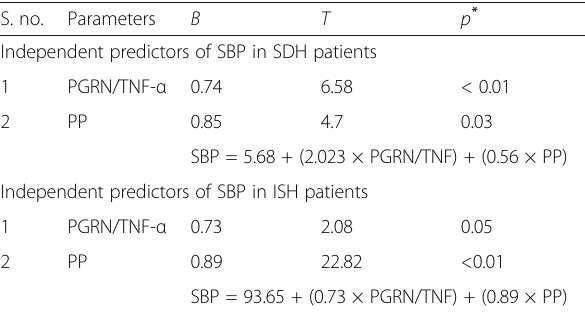
Table 2 Independent predictors of SBP S. no.